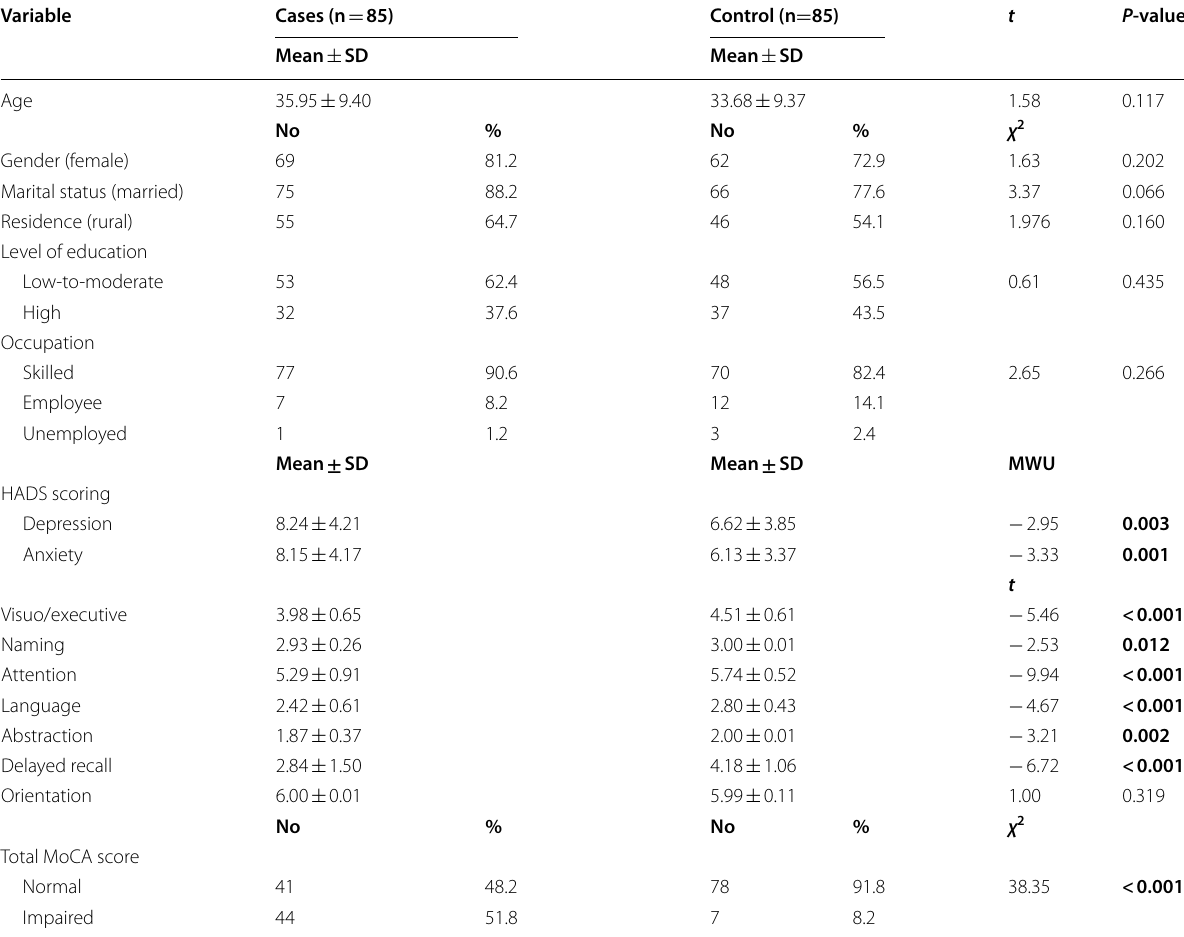
Table 1 Sociodemographic and clinical characteristics of COVID-19 survivors and control subjects